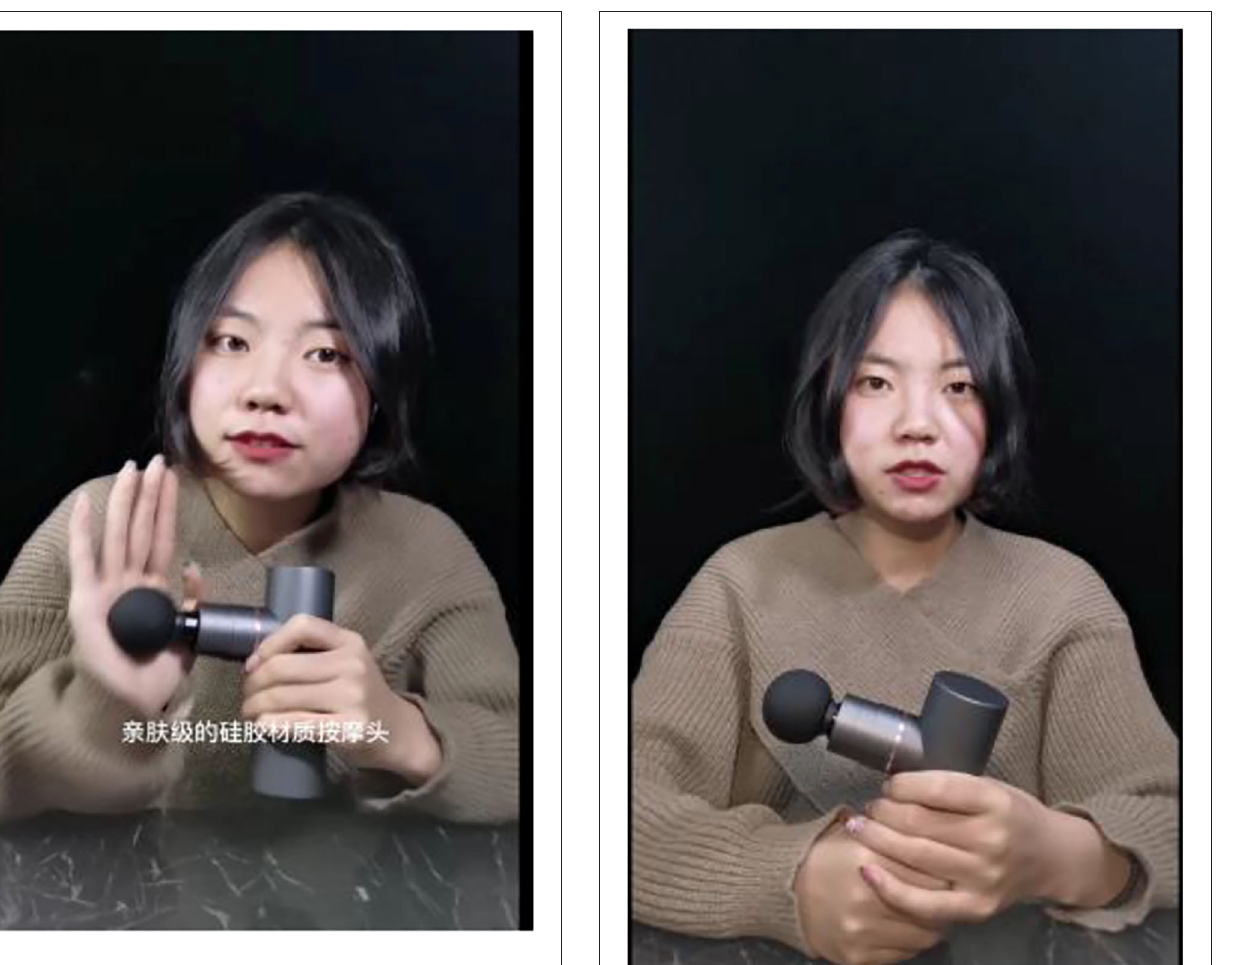
FIGURE 2 | A1 Screenshot of high social presence.